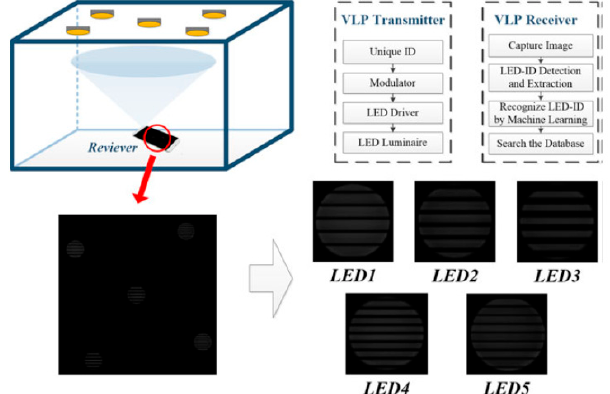
Figure 2. The process of the LED-ID detection and recognition base on machine learning.